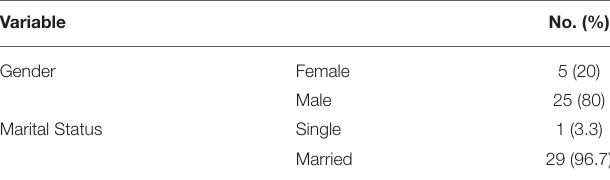
TABLE 1 | Demographic variables of the clergy participating in the workshop.